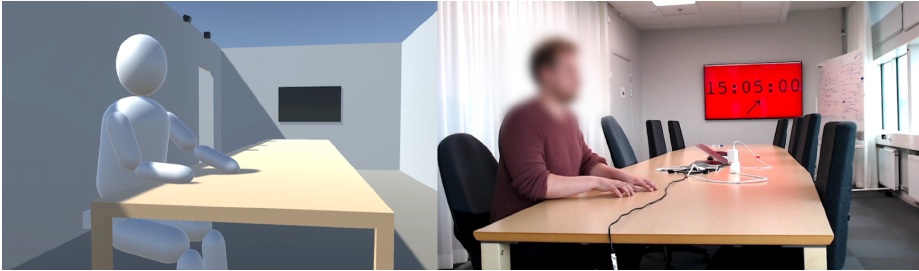
Figure 4. Snapshot taken from the simulated version of the experiment in Study A ( left ) and the real-world version of the same experiment ( right ). In both instances seat S1 is being